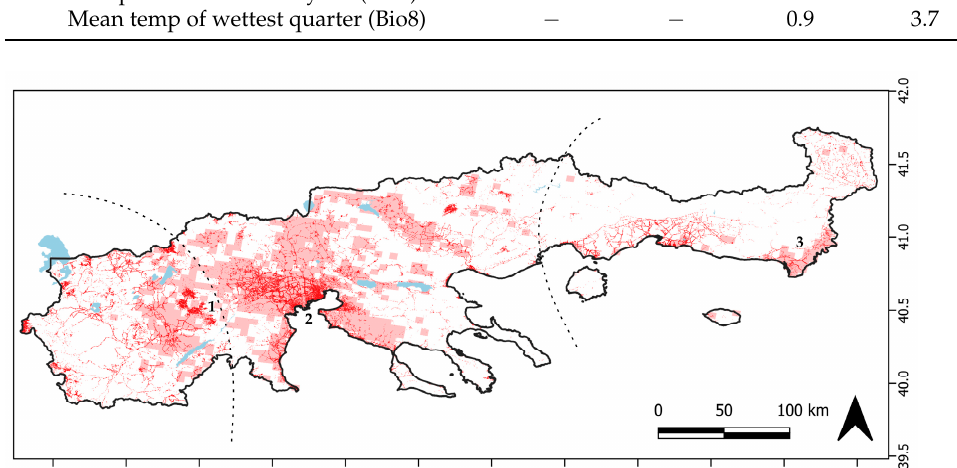
Figure 2. Map of Spermophilus citellus current habitat availability (dark red, resolution 100 m) and habitat suitability (light red, resolution 4.5 km) across the species’ historical range. The dashed lines separate the three sub-populations (Western Macedonia, Central Macedonia, and Thrace), while the numbers indicate the main available habitats of the species in ( 1 ) Mount Vermio, ( 2 ) Axios River valley and eastern Thessaloniki, and ( 3 ) Delta Evros River.